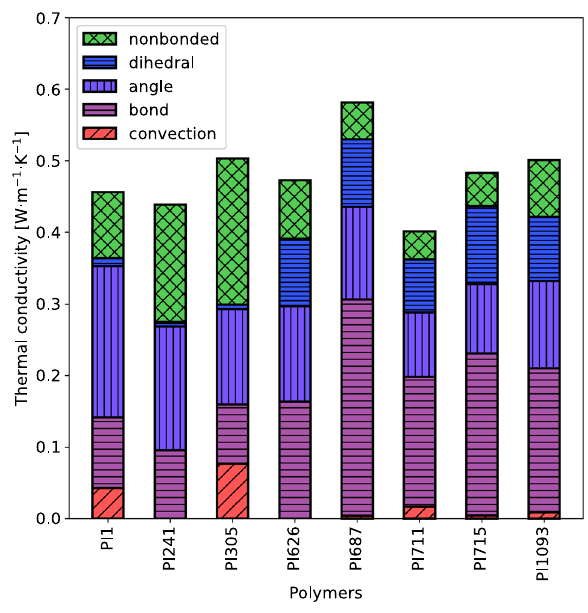
Fig. 6 Contributions of convection and different types of interactions to the calculated high thermal conductivities of the eight polymers. The colors in the bar chart mean convection (red), bond stretching (purple), bond angle bending (violet), dihedral (blue), and nonbonded (green)